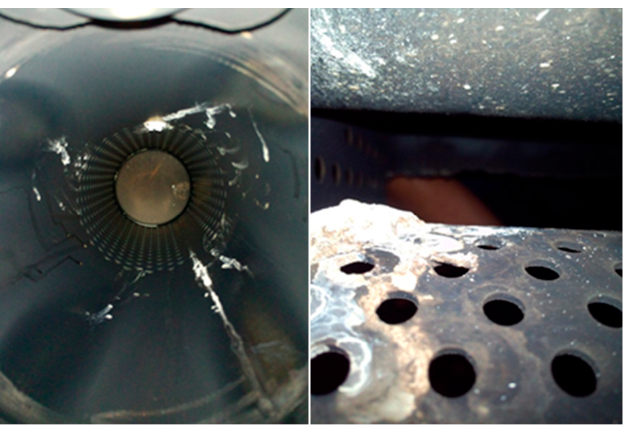
Figure 22. Both sides of the perforated pipe are at the entrance of the catalytic converter.